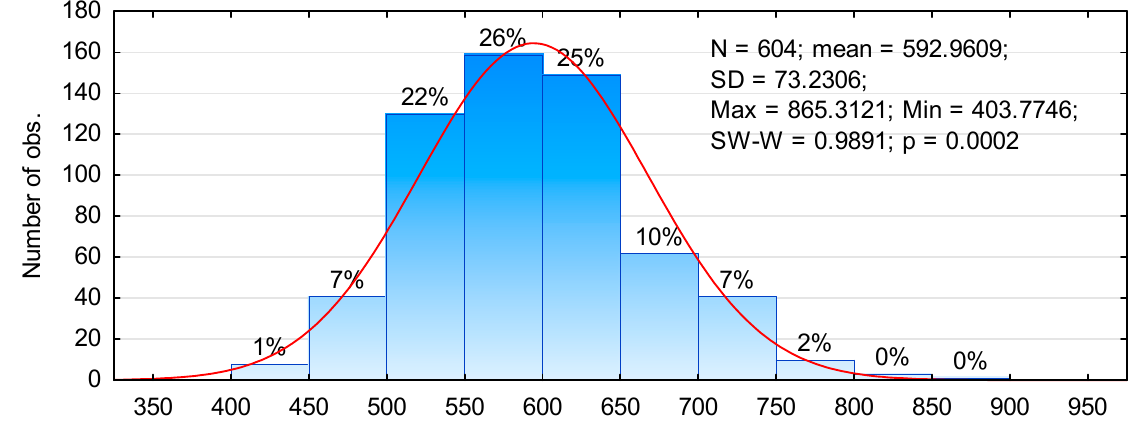
Figure 6. Histogram of the distribution of density.